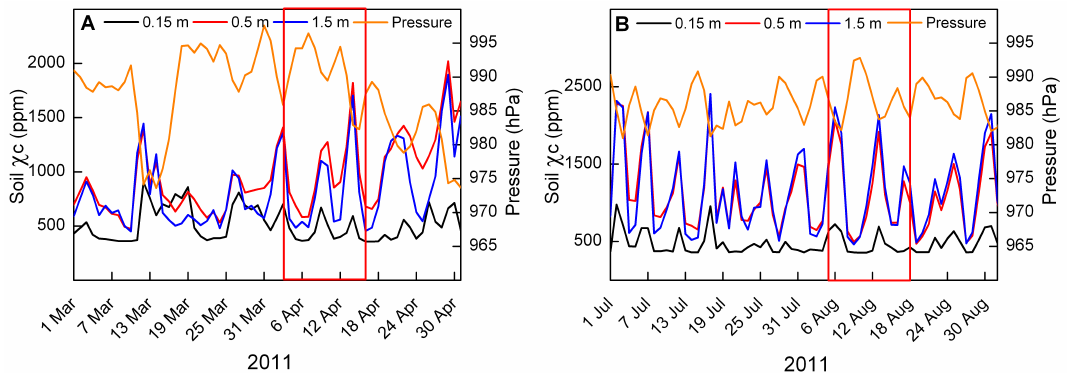
Fig. 2. Average daily values at 0.15m (black), 0.5m (red) and 1.5m (blue) depth of soil CO 2 molar fraction ( χ c ) and atmospheric pressure (orange) during two months for the growing period (panel A, March–April) and dry period (panel B, July–August). The red rectangle delimits the period amplified in Fig. 3.